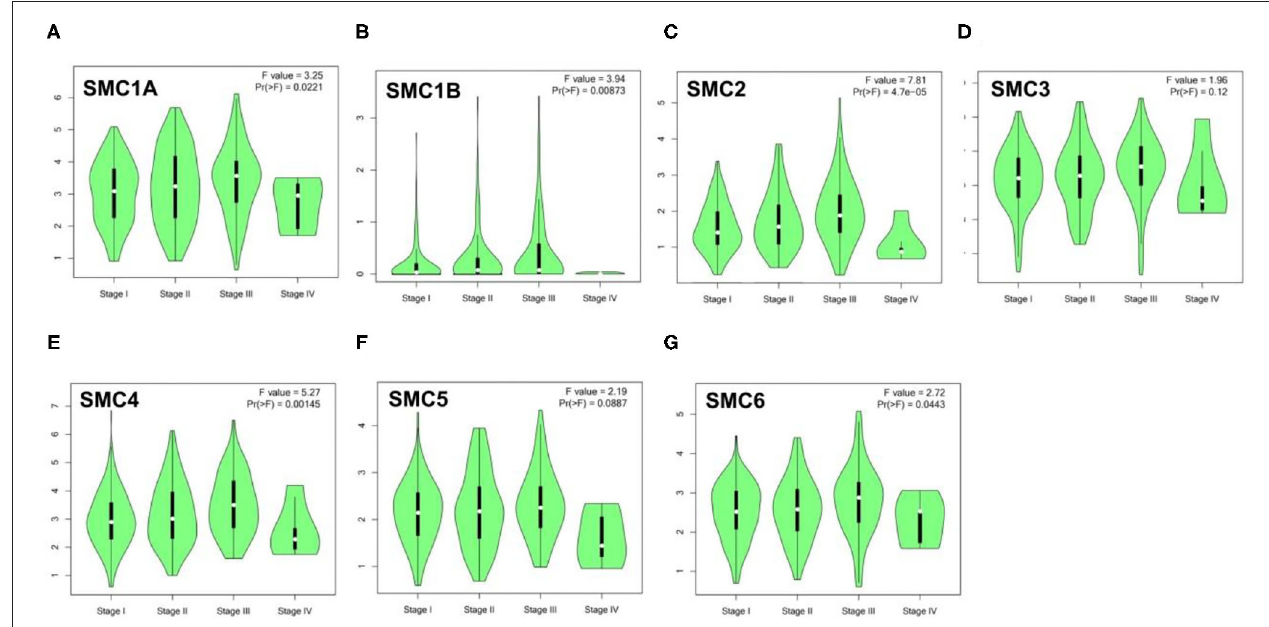
FIGURE 3 | Relationship between the expression level of SMC family members and HCC tumor staging. (A-G) GEPIA database was used to evaluate the correlations of the expression of SMC1A , SMC1B , SMC2 , SMC3 , SMC4 , SMC5 , and SMC6 with the pathological stage of HCC patients.